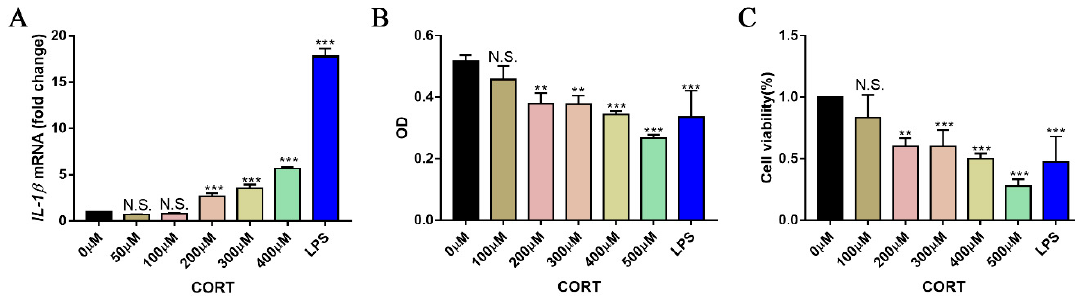
12 of 20 Figure 8. Expression of intracellular signaling pathway components in the hippocampus of cold- stressed mice. ( A ) Acetyl-p65 (Lys310), p65, silent mating type information regulation 2 homolog (SIRT)1, and β -actin levels were evaluated by western blotting. ( B , C ) High-mobility group box (HMGB)1 protein expression and acetylation in hippocampus tissue was evaluated by western blotting (B) and co-immunoprecipitation (co-IP) (C). ( D – F ) Quantification of expression levels based on HMGB1/ β -actin (D), acetyl-p65/p65 (E), and SIRT1/ β -actin (F) ratios. Differences between room temperature male (RTM) and cold exposure male (CEM), room temperature female (RTF) and cold exposure female (CEF), and CEM and CEF groups were evaluated by two-way analysis of variance. Results are expressed as the mean ± SD ( n = 6) of four independent experiments. N.S.: not significant; * p < 0.05, ** p < 0.01, *** p < 0.001. 3.5. Excess CORT Activates BV2 Cells To determine whether BV2 cells are activated by excess CORT and establish the range of effective concentrations, we assessed the effect of CORT on BV2 cell viability and activation. Cells were treated with different concentrations of CORT (0–500 μ M) for 3 h and the IL-1 β level was measured by qRT- PCR; cell viability was evaluated with the CCK-8 assay, and glial cell activation was assessed by IBA-